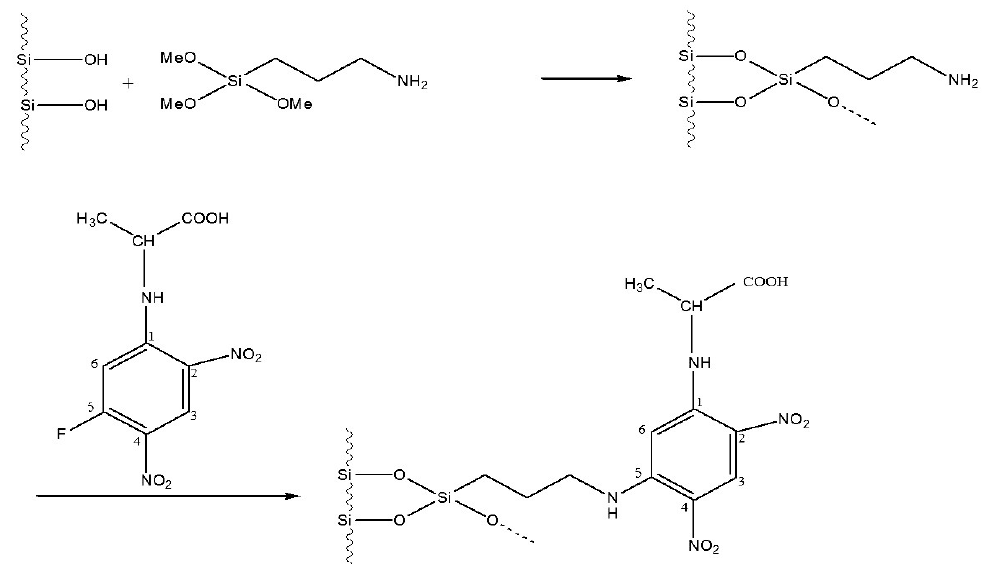
Figure 11. Linking of L - or D -DNP-alanine to silica (5 μ m) via the amine route [49].